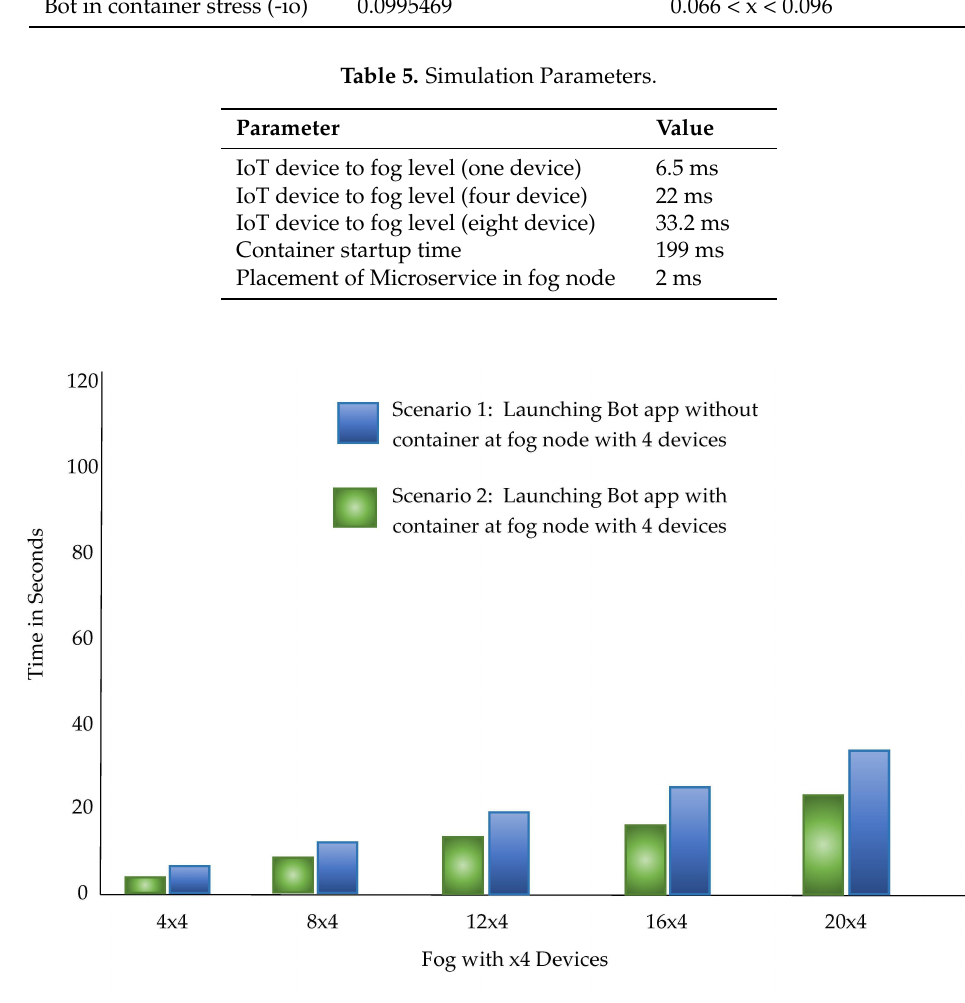
Figure 17. Time taken to place microservice in fog node with four